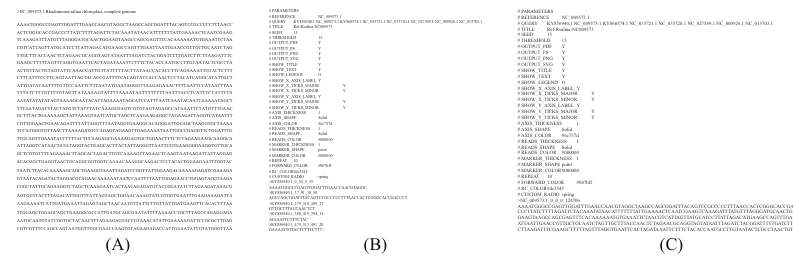
Figure 8. Sample input file and the resultant output file. ( A ) Input file (nucleotide.fasta). ( B ) Out- put file that aligned sequence from the optimal alignment step. ( C ) Output file that rearranged query